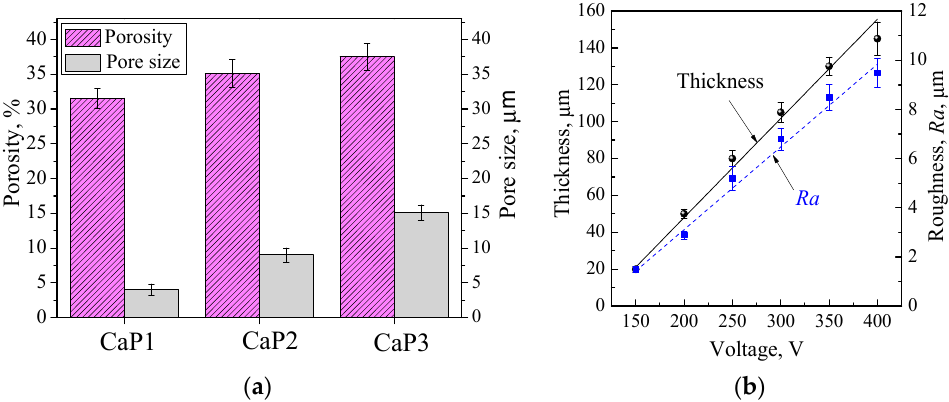
Figure 5. Dependences of the porosity and pore sizes ( a ) and thickness and roughness R a ( b ) of the CaP coatings on the process voltage.